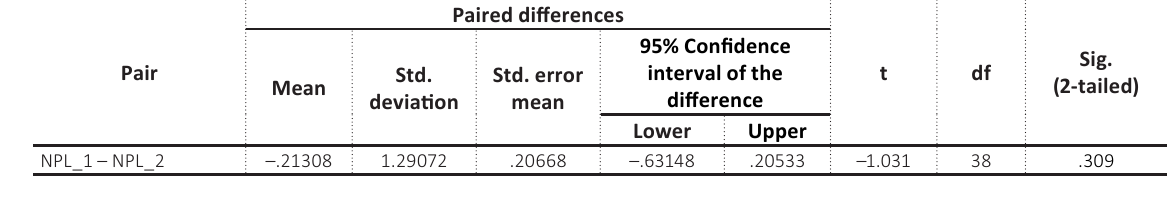
Table A11. Paired samples correlations (the result of H3b )